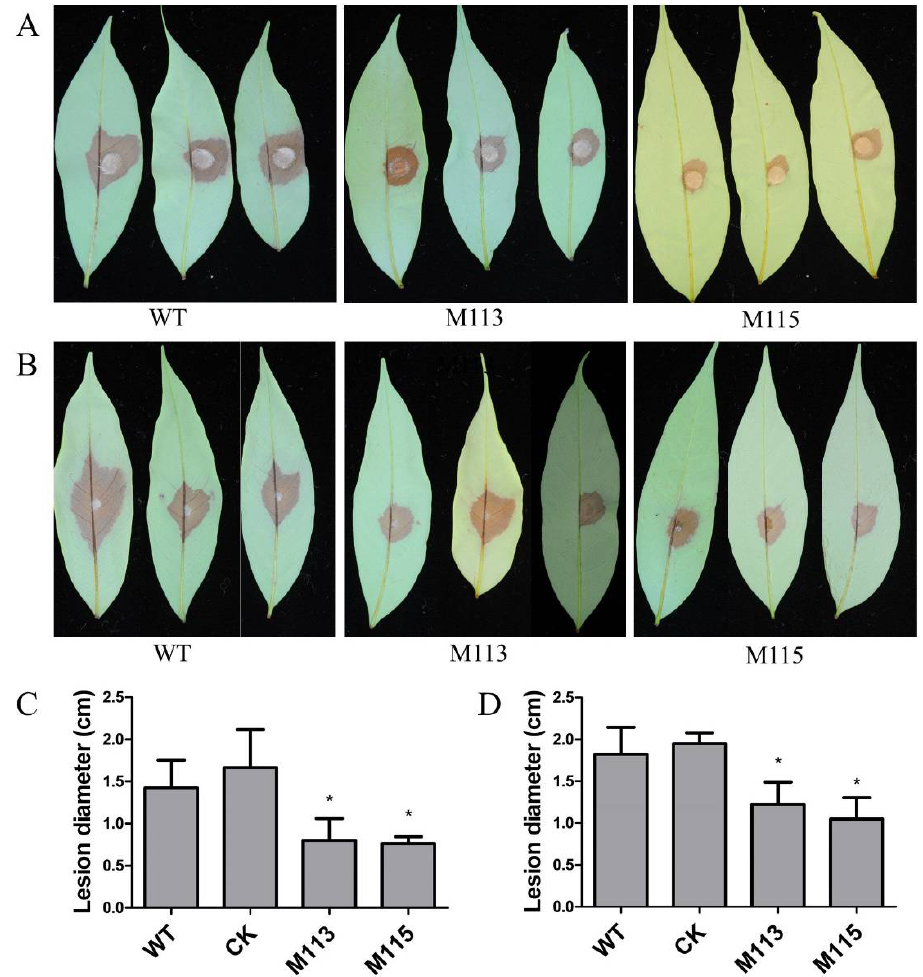
Figure 6. Infection assays with WT and the PlMAPK2 mutants. The virulence of PlMAPK2 mutants were tested on lychee leaves, with WT (wild type) as the positive control. Mycelium plugs ( A ) and sporangia ( B ) were inoculated on the lychee leaves, respectively. Photographs were taken 48 h after inoculation. ( C , D ) The lesion lengths were calculated 2 days after inoculation, corresponding to (A) and (B), respectively. CK: the transformant failed to acquire PIMAPK2 mutation. Asterisks indicate significant difference ( t -test, p < 0.01). These experiments were replicated three times, 5 leaves were calculated for each strain each time.